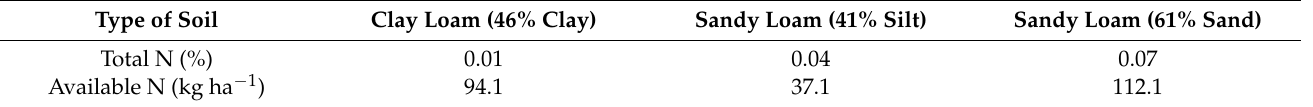
Table 4. Total and available N in different